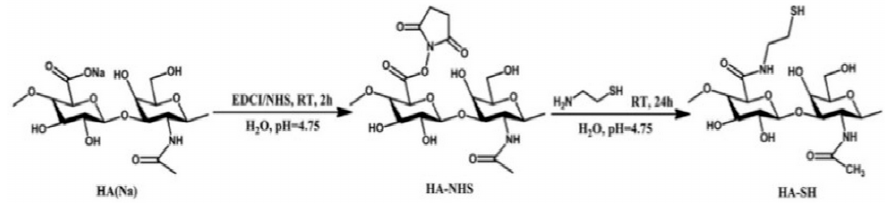
Figure 5. Synthesis scheme of thiol modified HA [52]. Reproduced with permission from Elsevier, 2016.